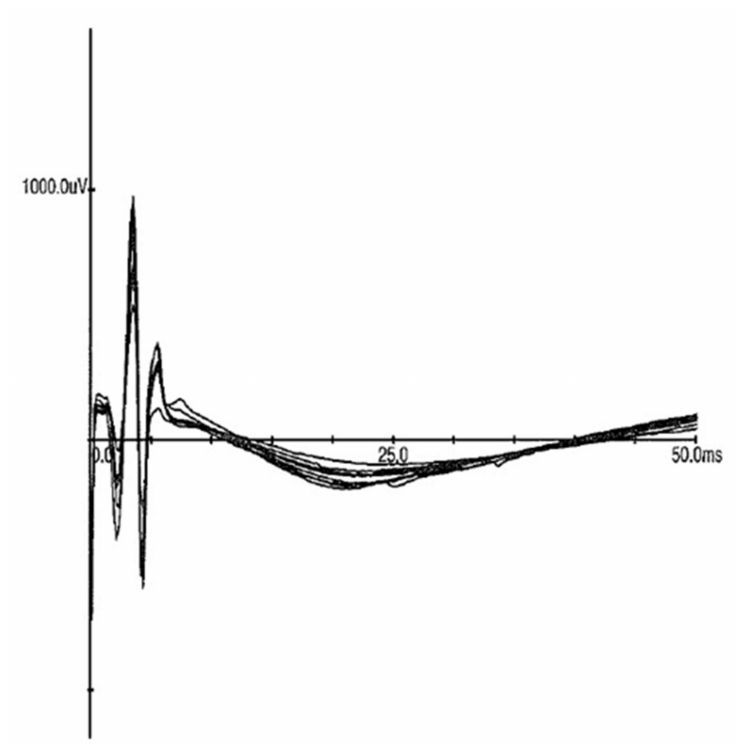
Figure 6. Stimulation provided through metal electrodes with the cathode handheld against the nerve, producing CMAPs recorded with subdermal needle electrodes at 1 mA stimulating current. Eight successive CMAPS are overlaid.